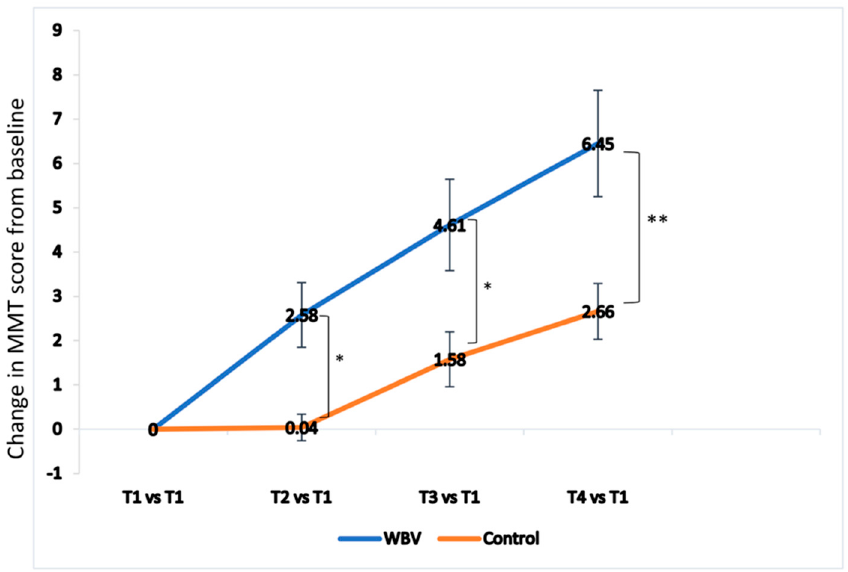
Figure 2. Time course of mean change in knee extensor strength from baseline by time of treatment.